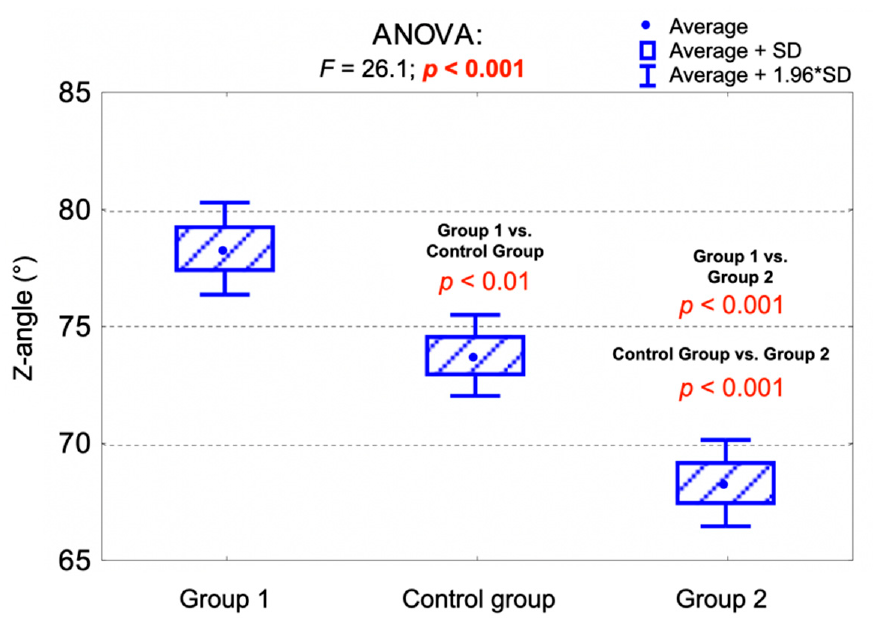
Figure 3. Comparison of the average Z-angle values among the examined groups and the results of the analysis of variance (ANOVA).